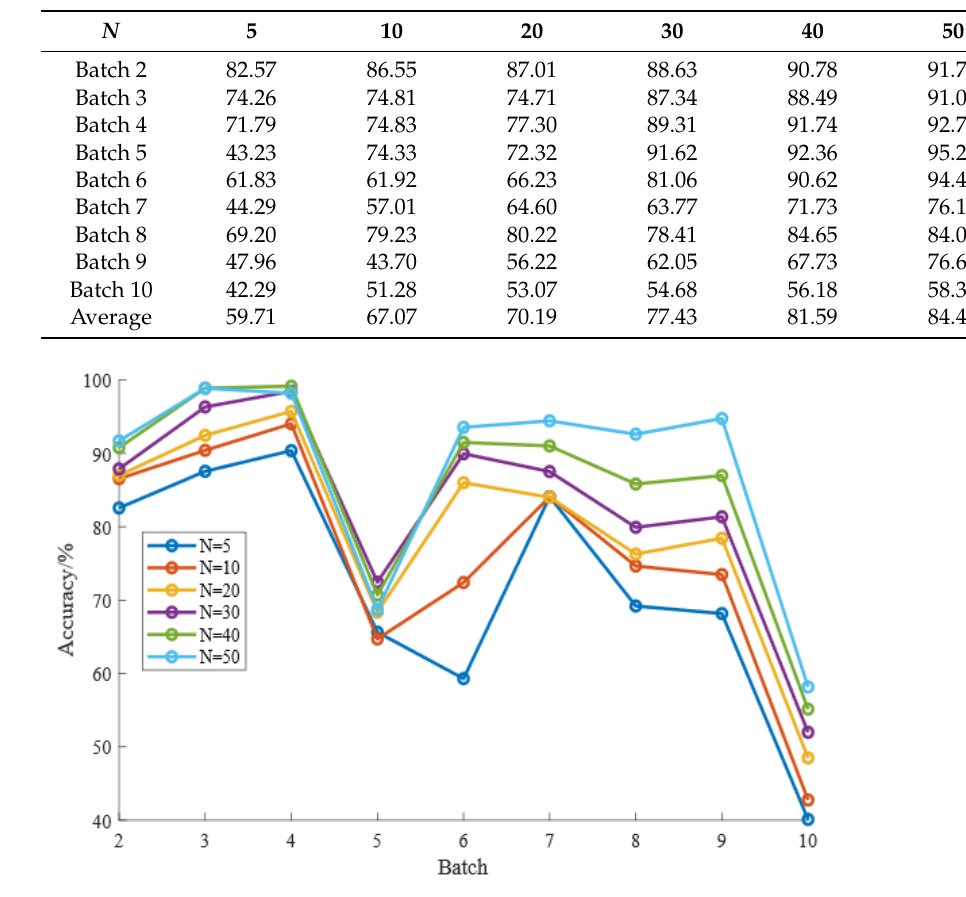
Figure 4. Effect of N on long-term drift. Table 6. Classification accuracy with different values of N on Setting 1.